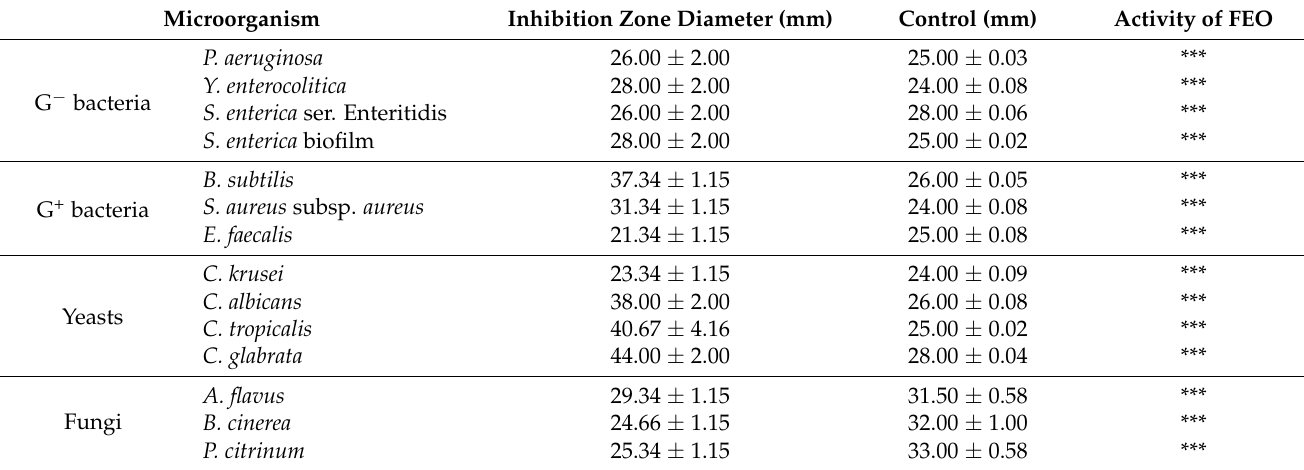
Table 4. Antimicrobial activity of FEO measured by disk diffusion